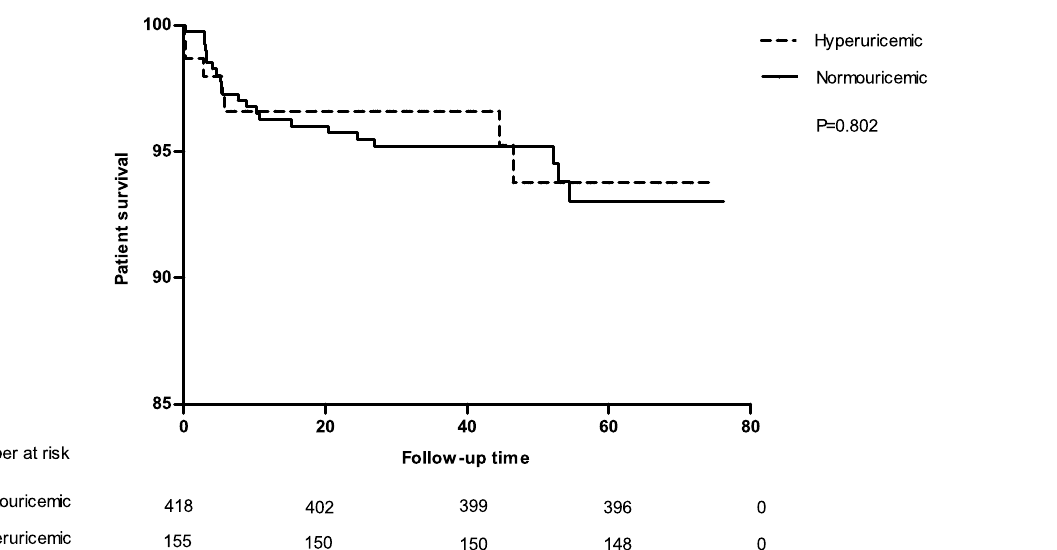
Fig 6. Kaplan-Meier survival curve estimates for death with functioning graft. No significant difference can be acquired on patient survival rate between these groups.